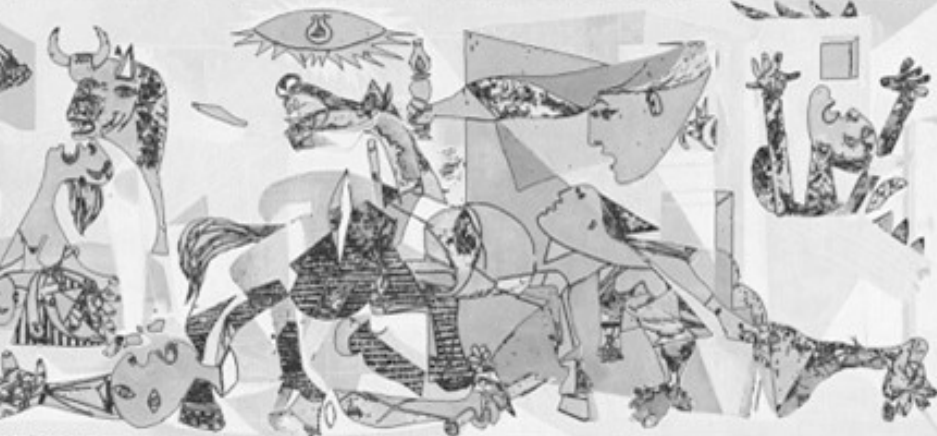
Montandon, Graphic reworking from Guernica by Pablo Picasso , 2021, digital